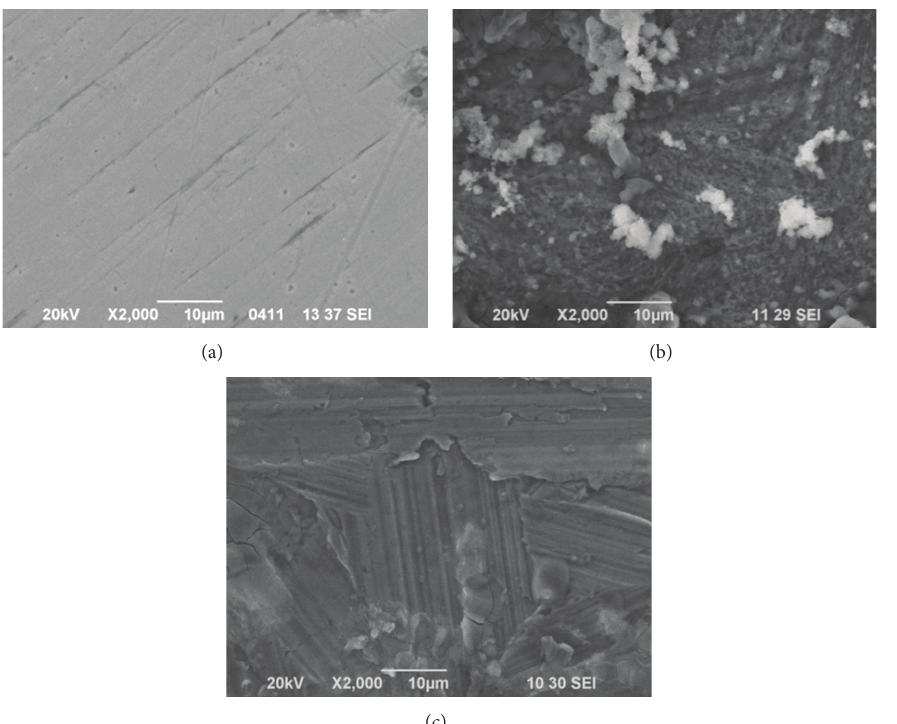
Figure 4: SEM micrographs of (a) carbon steel magnifications × 2000 (control);(b) carbon steel immersed insea water; magnifications × 2000; and (c) carbon steel immersed in sea water containing 250 ppm of L-Arg-25 ppm of Zn 2+ ; magnifications ×